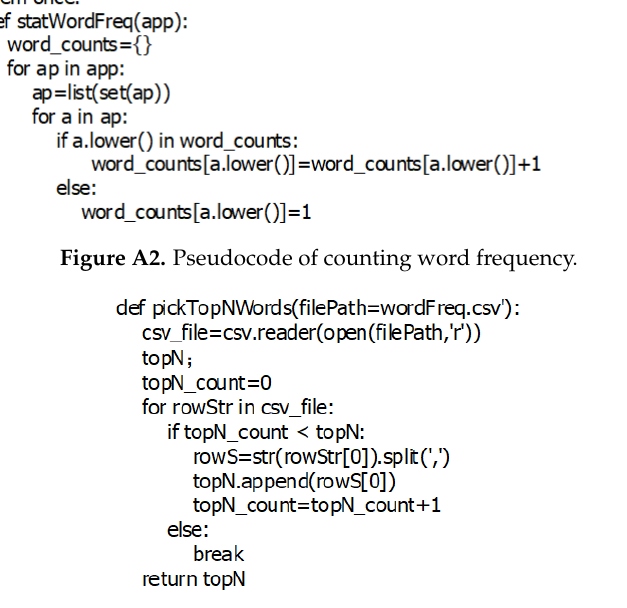
Figure A3. Pseudocode of obtaining high-frequency words.